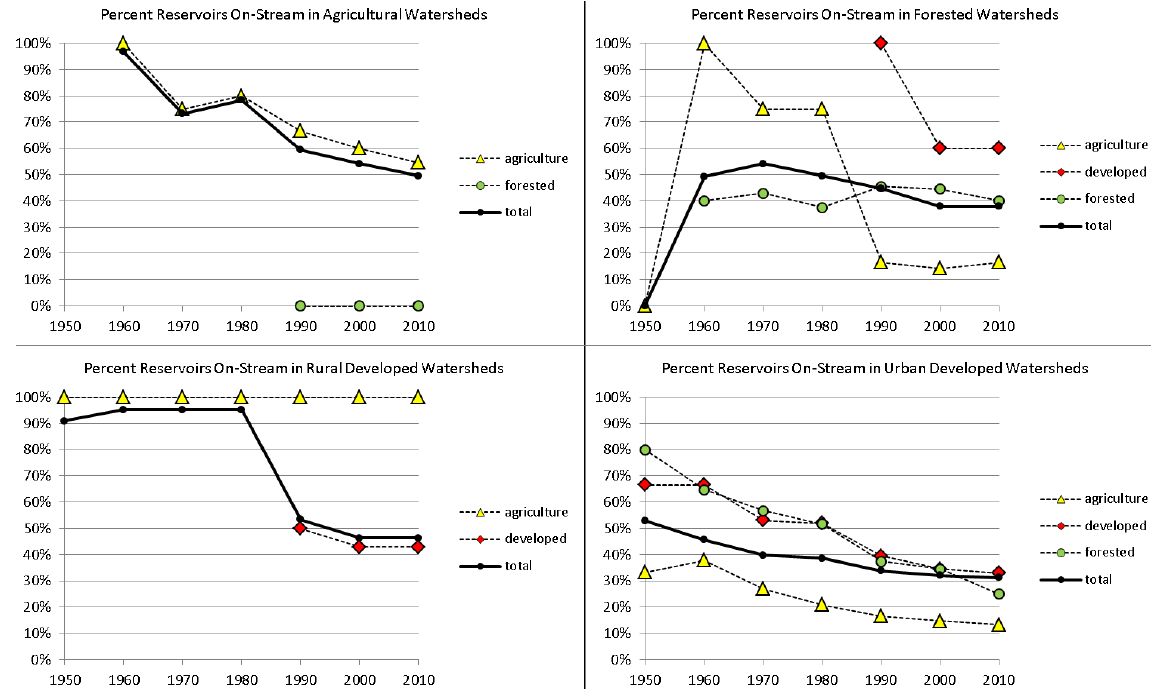
Figure 10. Percent reservoirs (classified by adjacent land cover) located on-stream and causing stream fragmentation (based on intersection with the National Hydrography Dataset Flowline) for agricultural, forested, rural developed, and urban developed watersheds, 1950–2010. Reservoirs created after 1980 are less likely to intersect streams than previously constructed